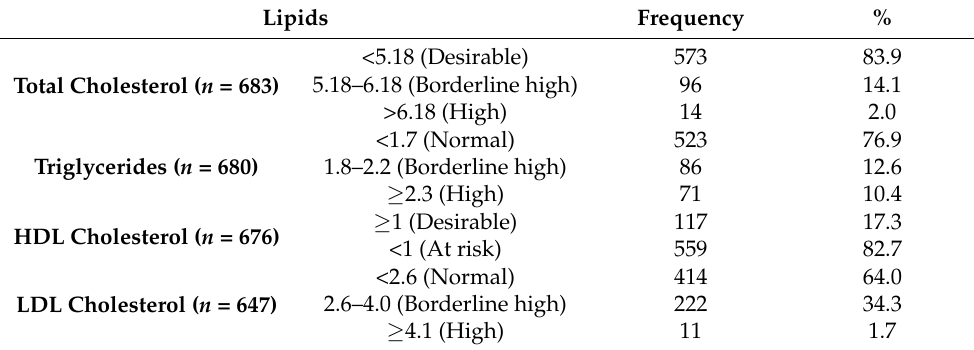
Figure 7. Pooled prevalence of dyslipidaemia in participants with HIV, diabetes, hypertension, and obesity. The cutoff for elevated total cholesterol was >6.18 mmol/L, elevated triglycerides were ≥ 2.3 mmol/L, reduced HDL cholesterol was <1 mmol/L, and elevated LDL was ≥ 4.1mmol/L.